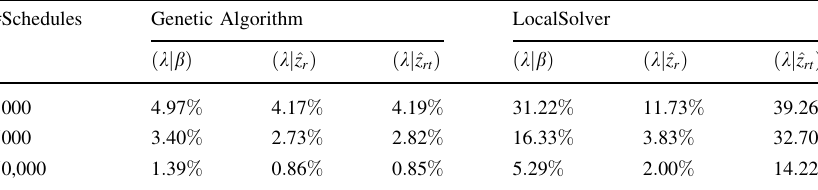
Table 7 Numerical results for large projects with 120 non-dummy